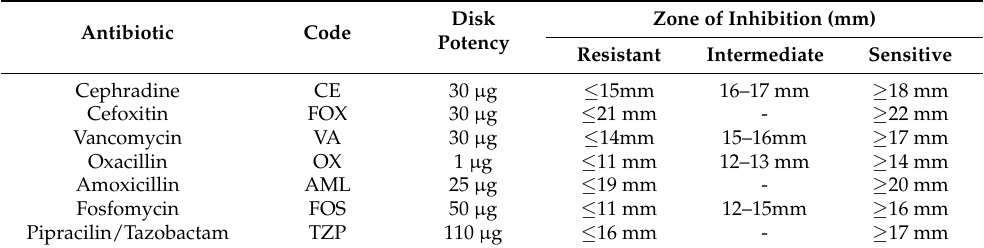
Table 4. Criteria for the analysis of antibiotics sensitivity for S. epidermidis [42,44].